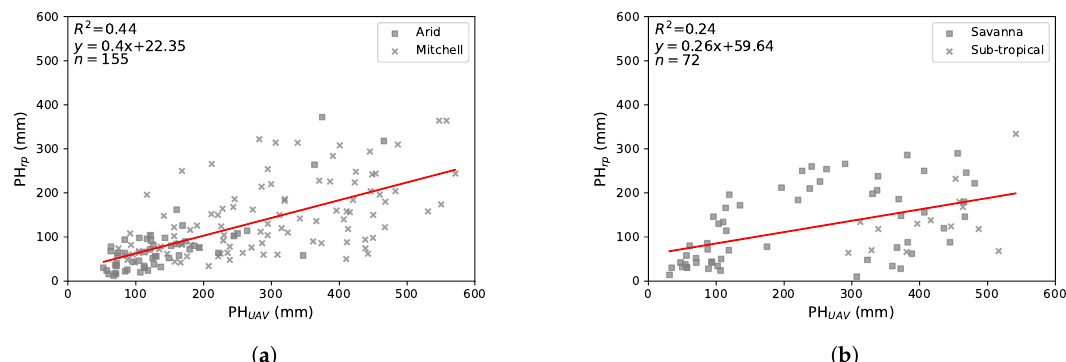
Figure 4. Least squares linear relationship between pasture height from UAV-based RGB imaging (PH UAV ) and manual rising plate meter measurements (PH rp ) for both the grassland ( a ) and woodland ( b ) categories along with each of their associated subcategories.